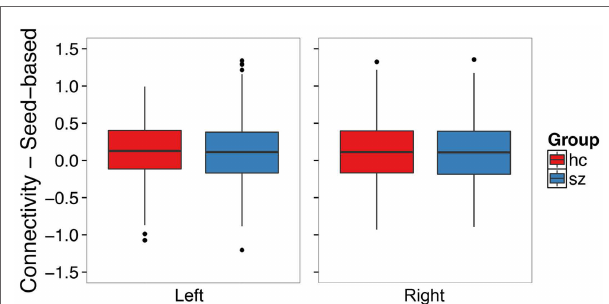
Figure 6 | seed-based functional connectivity with the default mode network does not differ between schizophrenia patients and controls in the left or right hippocampus . The boxplots show the median, interquartile range, and outliers. The whiskers extend to the lowest value within 1.5 times the quartiles.